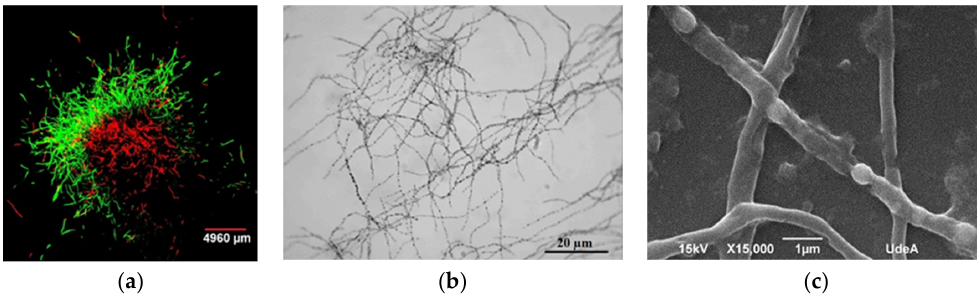
Figure 4. Observations of Streptomyces clavuligerus morphology: ( a ) Fluorescent staining of mycelia in TSB medium after 48 h of cultivation with FDA (green) and propidium iodide (red); ( b ) optical micrograph of mycelia at 120 h of culture in isolated soy protein based medium; ( c ) scanning electron microscopy of hyphae having separated compartments after 120 h of culture in isolated soy protein based medium.